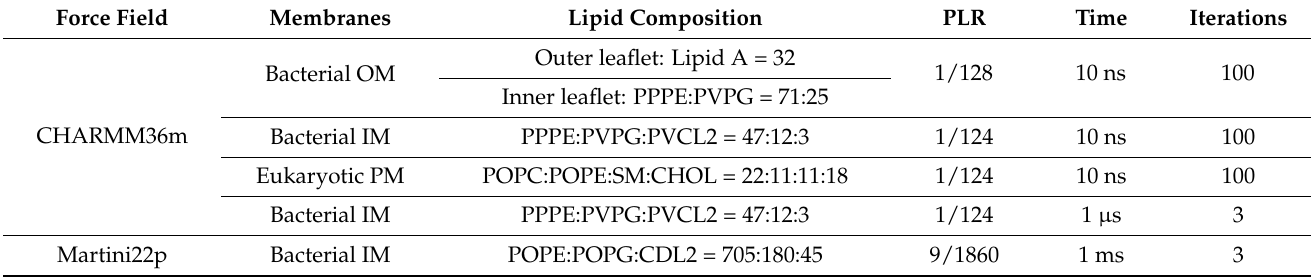
Table 1. Summary of molecular dynamics simulation systems.